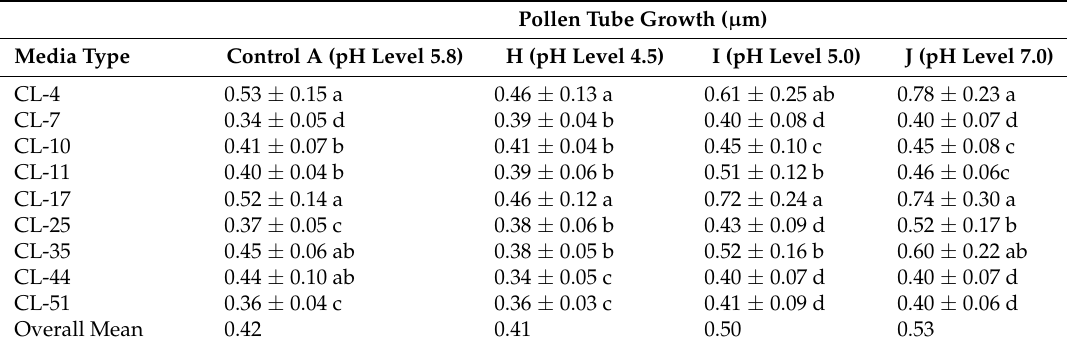
Table 7. Effects of pH level on pollen tube growth.